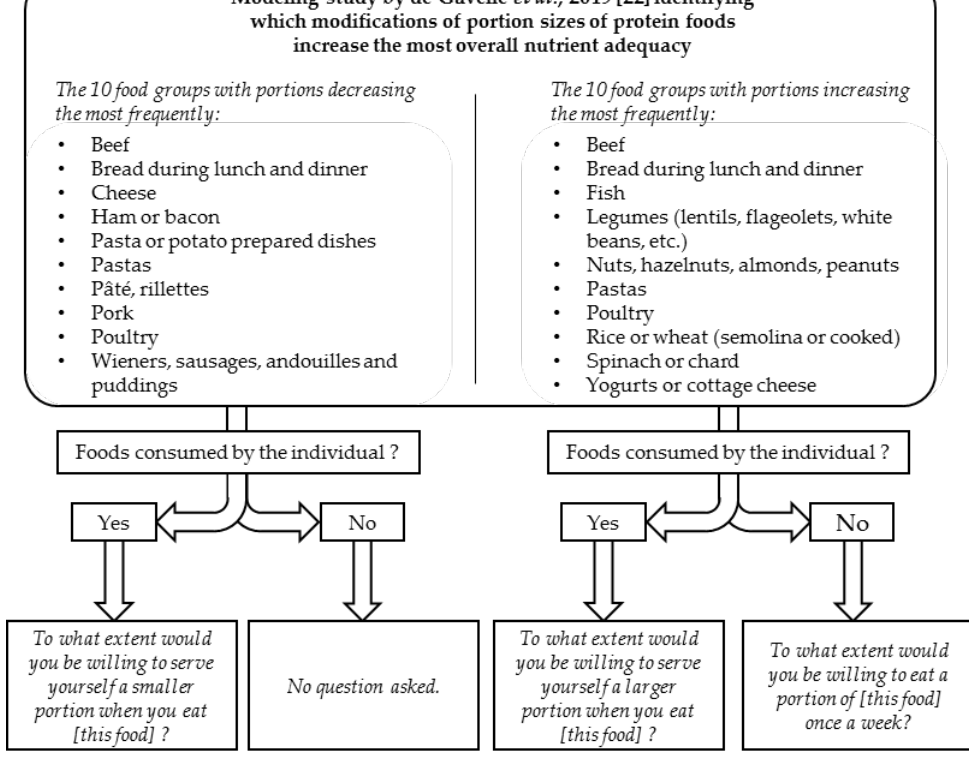
Figure 1. Questions related to the willingness to adopt changes to protein food intake which increase the nutrient adequacy of the diet (from 1 “not at all” to 7 “absolutely”).